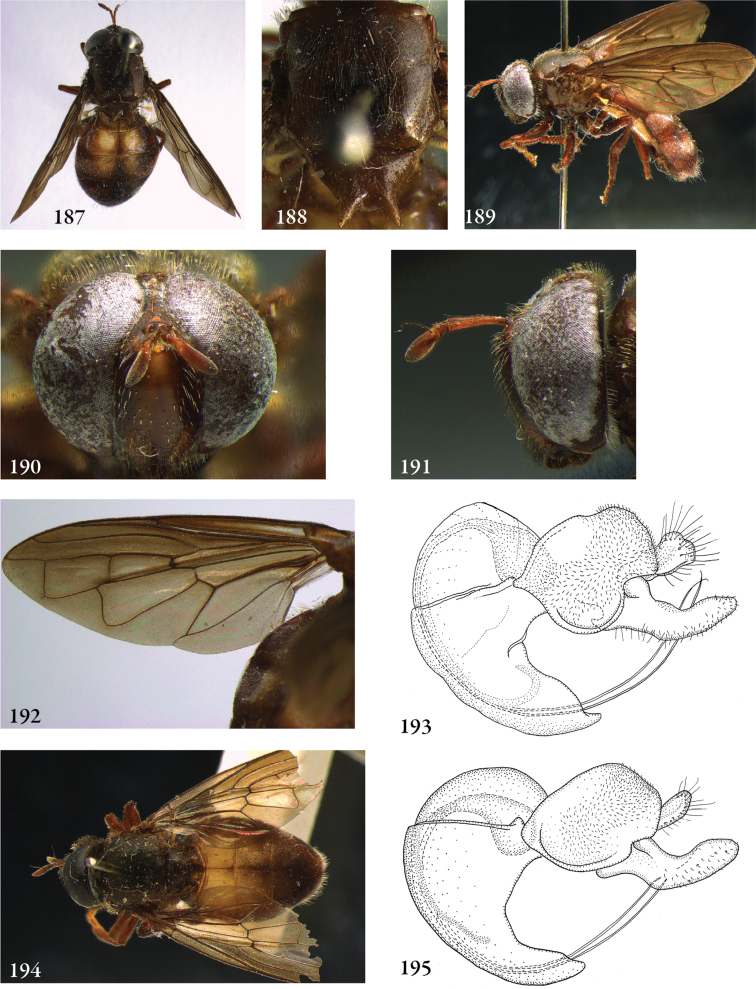
187–190
Microdon (Megodon) stuckenbergi male (holotype): 187 habitus dorsal 188 thorax dorsal 189 habitus lateral 190 head frontal 191–193
Microdon (Megodon) stuckenbergi male (holotype): 191 head lateral 192 wing 193 genitalia 194–195
Microdon (Megodon) planitarsus male (holotype): 194 habitus dorsal 195 genitalia.